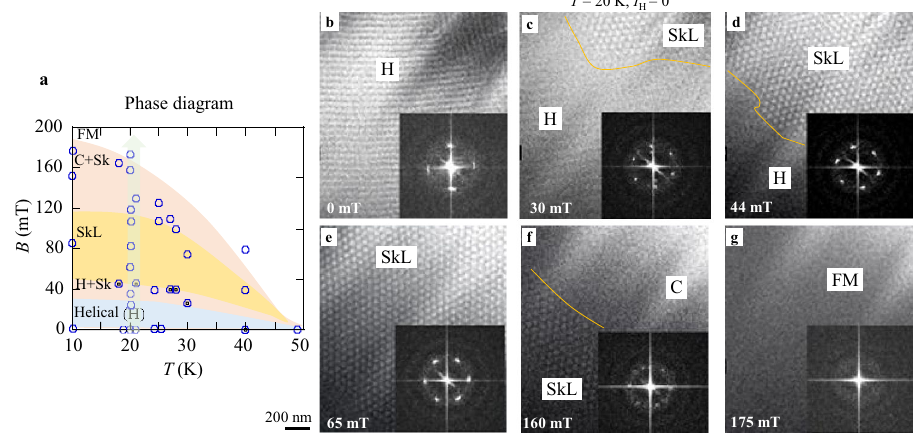
Fig. 2 The temperature ( T ) - magnetic fi eld ( B ) phase diagram observed in Cu 2 OSeO 3 by Lorentz TEM. a The T - B phase diagram of magnetic structure in the (111) 100-nm thick Cu 2 OSeO 3 thin plate. Circles specify the T and B conditions. H, C, and FM stand for the helical, conical, and fi eld-aligned ferromagnetic structures, respectively. b – g Lorentz TEM images and their fast Fourier transforms (FFTs) were observed at 20 K with an increasing magnetic fi hexagonal lattice during the current excitation. Figure. 3c, d show of skyrmions and C or FM domains to probe the temperature- two snapshots of over-focus Lorentz TEM images for a mixed gradient effect on skyrmions. state with a skyrmion domain and possible vertical- C domain (monotonic contrast in the images), observed at a static state Skyrmion dynamics in the microdevice under low heat fl ow . (Fig. 3c) and during (Fig. 3d) a 50- μ A-current excitation at an Figure. 3a, b show two isolated islands of skyrmions observed elapsed time of 1.16 s, respectively. The facets of the hexagonal before (Fig. 3a) and during (Fig. 3b) a 10- μ A-current excitation lattice of skyrmions as the domain walls between skyrmion on the heater at an indicated elapsed time (0.8 s), respectively. domain and C domain, indicated by yellow dashed lines in The center position of the skyrmion island does not change sig- Fig. 3c, drift from the cold region to the hot region (right side), ni fi cantly in spite of the change of orientations (indicated by accompanying a constriction of the C domain and possible yellow and orange dashed lines in Fig. 3a, b, respectively) of its